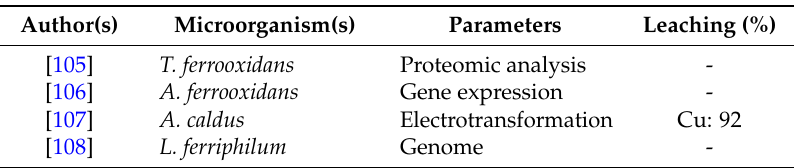
Table 8. Molecular studies research according to the parameters studied and recoveries achieved as well as microorganisms used. The articles appear in chronological